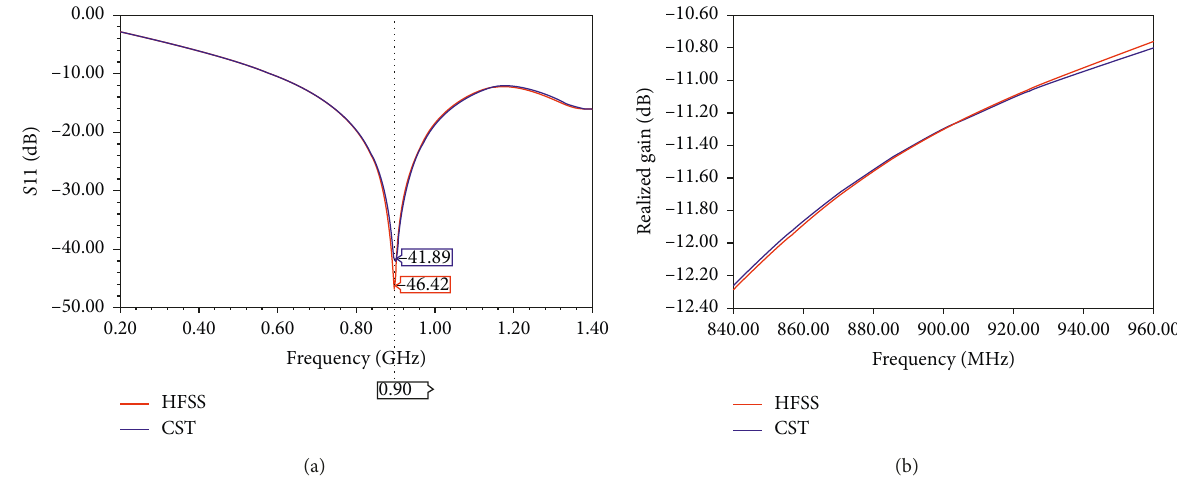
Figure 19: Comparison of S 11 (a) and realized gain (b) results of the second antenna performed with the Ansoft HFSS and CSTsoftware.